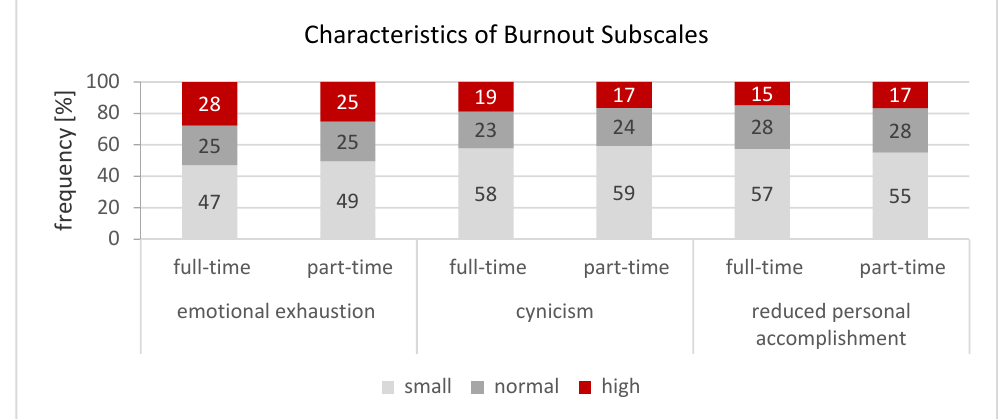
Figure 1. Characteristics of burnout subscales of full-time ( n = 6109) and part-time teachers ( n = 5905). Comments: χ 2 -test (Pearson); χ 2 : test size; significance (two-sided); d: effect size (emotional exhaustion: p = 0.007, d = 0.057, no effect; cynicism: p = 0.002, d = 0.064, no effect; reduced personal accomplishment: p < 0.001, d = 0.104, no effect) [59].